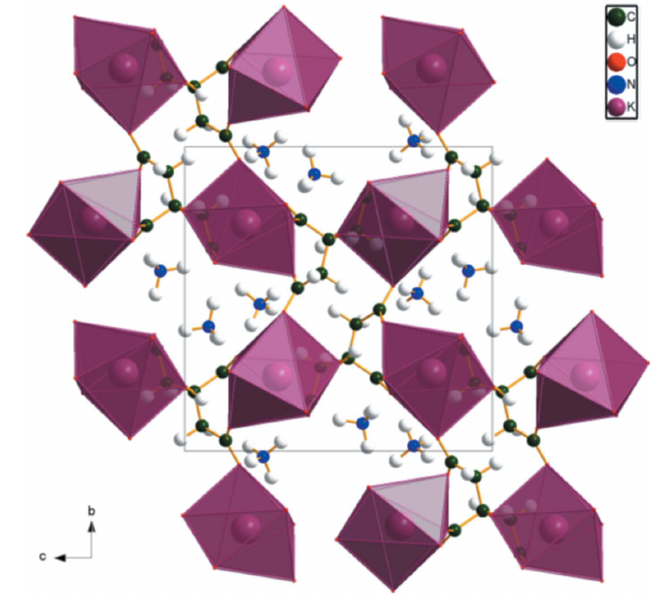
Figure 3 The crystal structure of (NH 4 ) 2 KC 6 H 5 O 7 , viewed along the a axis.